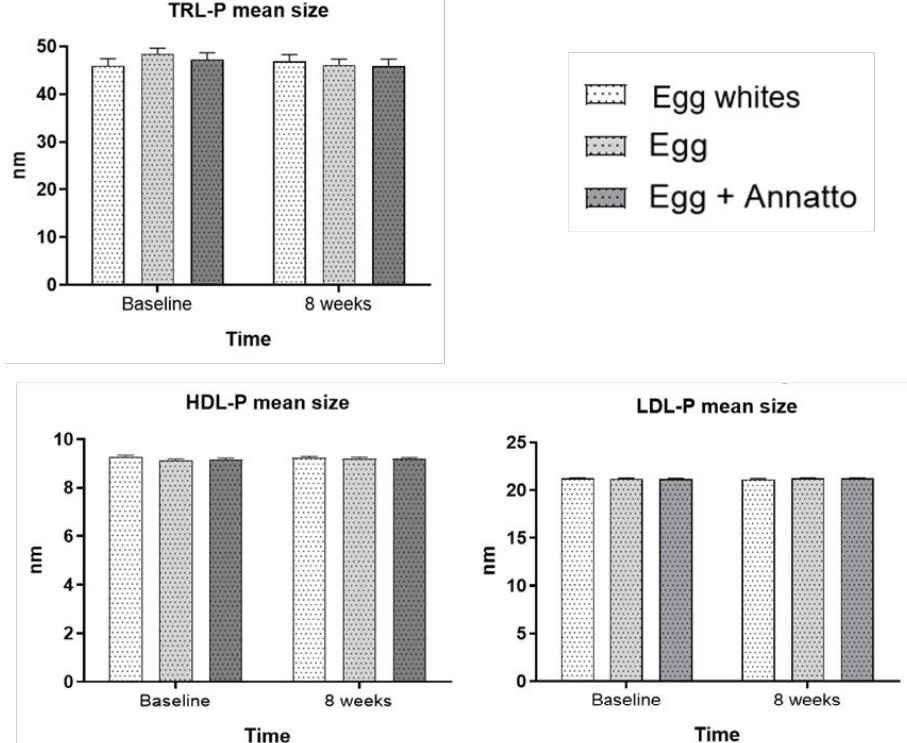
Figure 3. Mean triglyceride-rich lipoprotein particle (TRL-P), low-density lipoprotein particle (LDL- P), and high-density lipoprotein particle (HDL-P) sizes at baseline and after 8 weeks of consumption of egg whites, egg, or egg + Annatto. Repeated-measures ANOVA. Significance of treatment, time, and time x treatment p < 0.05 for all lipoprotein subclasses.